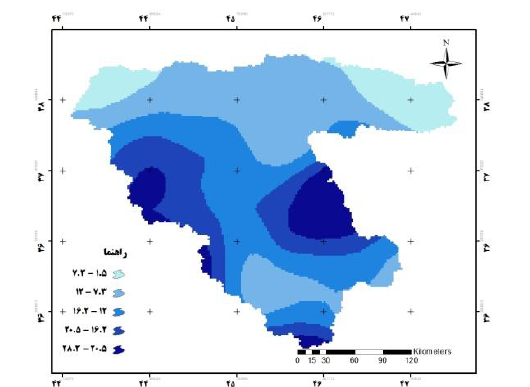
Figure 18: Interpolation of TRMM precipitation data over the catchment basin of Urmia lake (April 21 st )